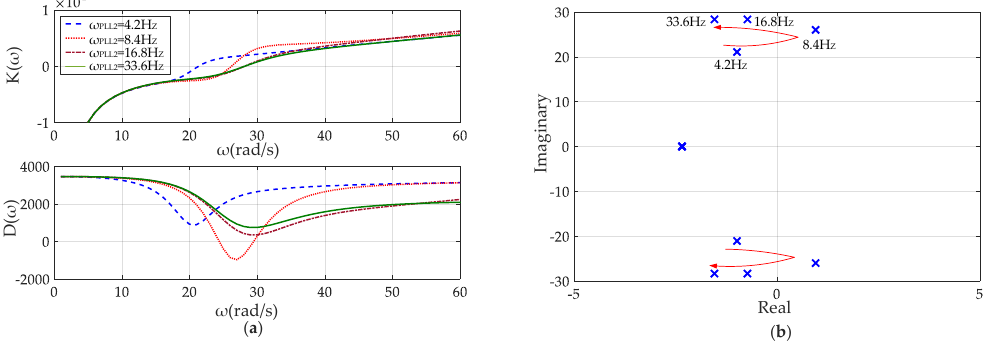
Figure 10. ( a ) Frequency response curves of spring and damping coefficients for the entire system under different bandwidths of PLL; ( b ) corresponding eigenvalue locus. under di ff erent bandwidths of PLL; ( b ) corresponding eigenvalue